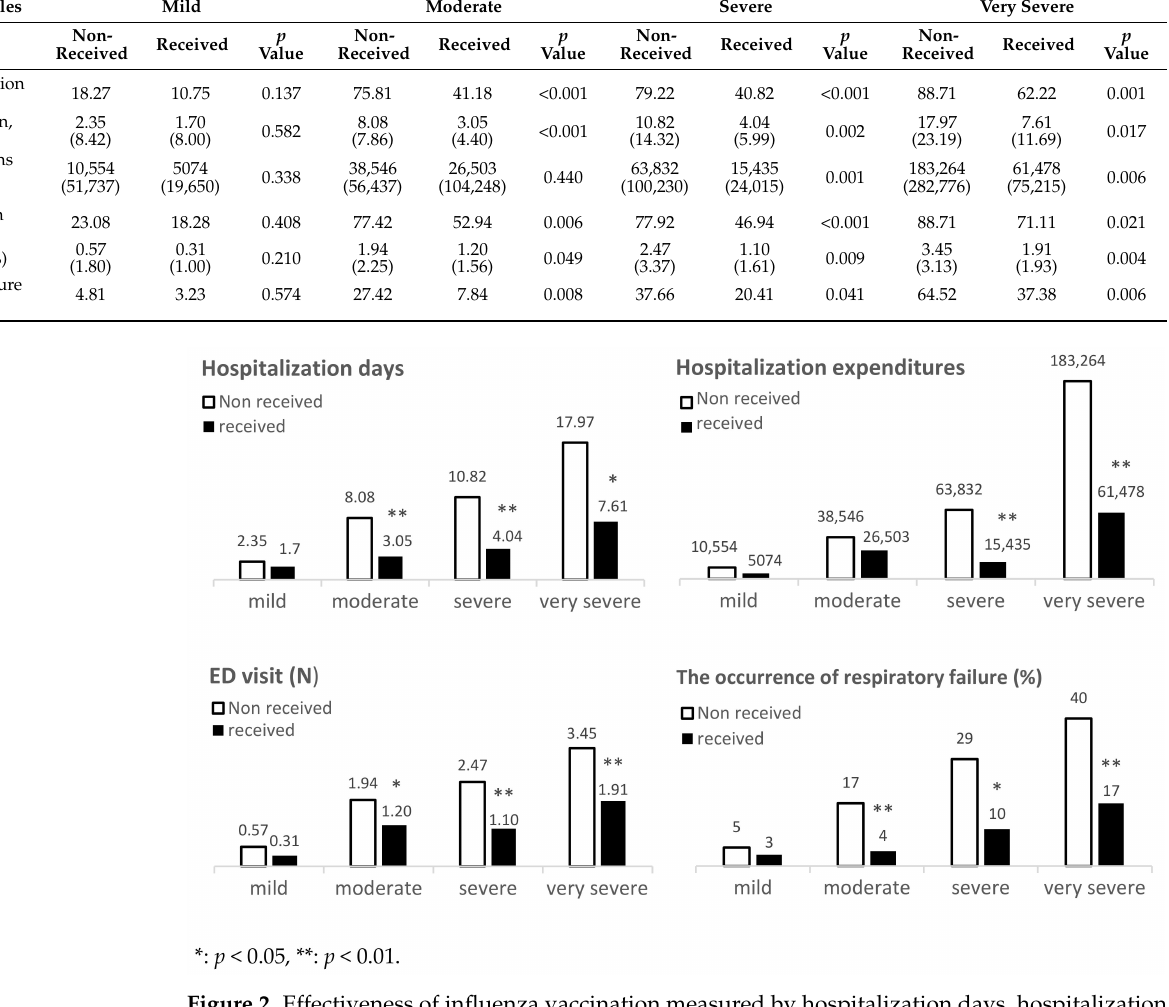
Figure 2. Effectiveness of influenza vaccination measured by hospitalization days,